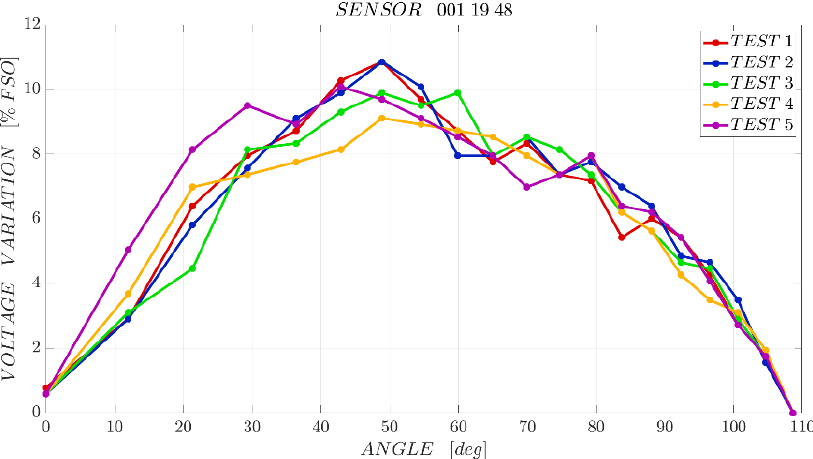
Figure 19. Example of a sensor hysteresis evaluation.